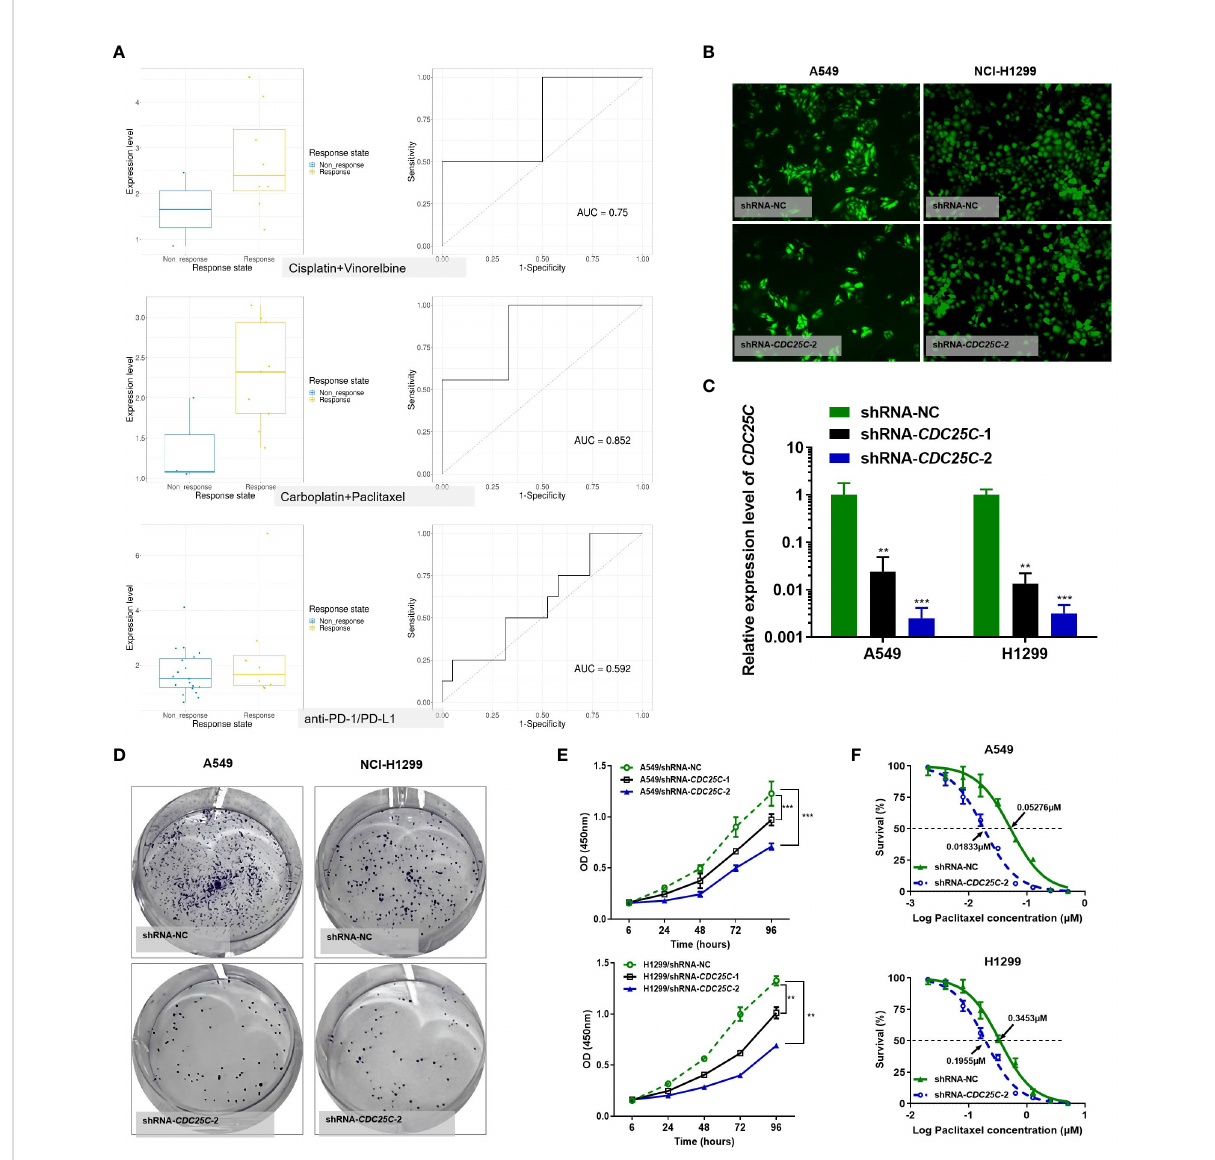
FIGURE 10 Effects of CDC25C knockdown on proliferation and chemosensitivity in NSCLC cells. (A) Drug response analysis by Cancer Treatment Response gene signature DataBase (CTR-DB). (B) Immuno fl uorescence was performed 72 h after transfection. (C) Expression of CDC25C mRNA by qRT-PCR in A549 and NCl-H1299 cells transfected with shRNA-NC and shRNA-CDC25C. (D) Plate colony formation assay (n=3). (E) CCK8 detection of the proliferation of shRNA-CDC25C-transfected A549 and NCl-H1299 cells (n=4). And all data are illustrated as mean ± SD;.NS, no signi fi cance; *p<0.05; **p < 0.01; ***p < 0.001; and ****p < 0.0001. (F) Drug sensitivity of Paclitaxel was represented by the half-maximal inhibitory concentration (IC50) (n =